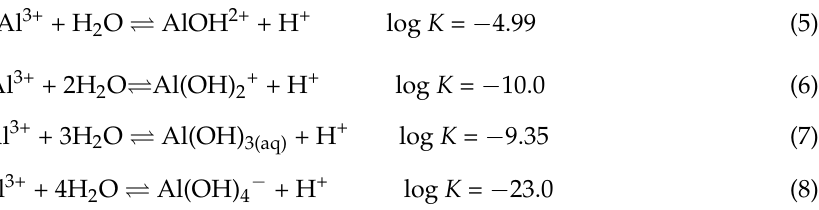
Figure 6. The polymerization reaction between Si(OH) 4 and H 3 SiO 4 − .